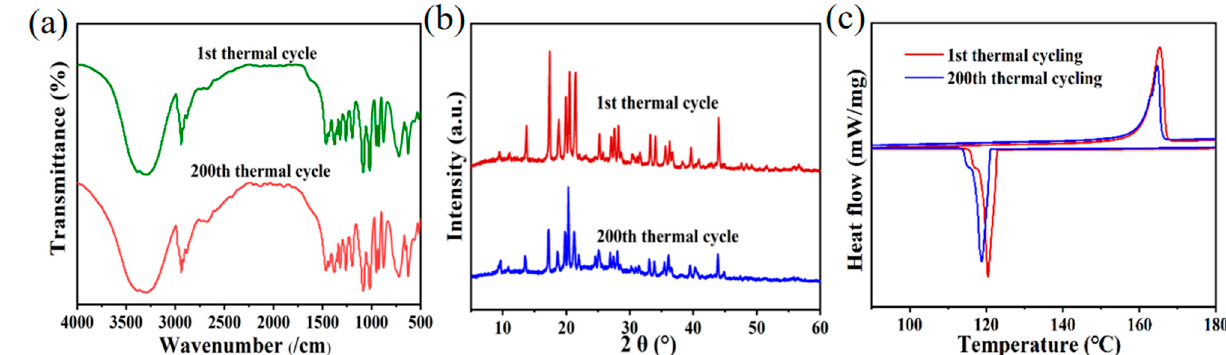
Figure 8. ( a ) XRD, ( b )FTIR, and ( c ) DSC curves of the YC/D-mannitol after 200 cycles. After 200 cycles of heating charge and discharge, YC/D-mannitol had 4.00% η m while η c was 2.15%. The supercooling was only changed by 0.75 ◦ C. Therefore, rapid energy release was also realized using the reused YC/D-mannitol (Table 4). Table 4. Thermal properties of the YC/D-mannitol before and after 200 cycles of charge and discharge.